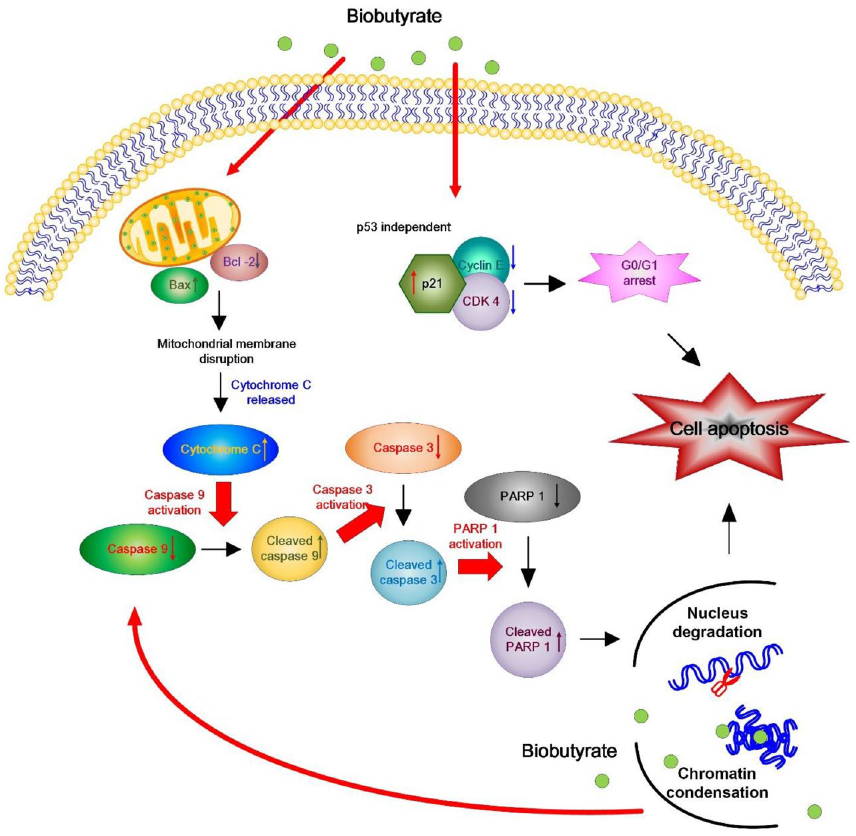
Figure 8. Schematic diagram showing the effect of biobutyrate on the mitochondrial apoptosis pathway and the cell cycle regulation. Biobutyrate causes the cell cycle arrest and induces cell apoptosis in HT29